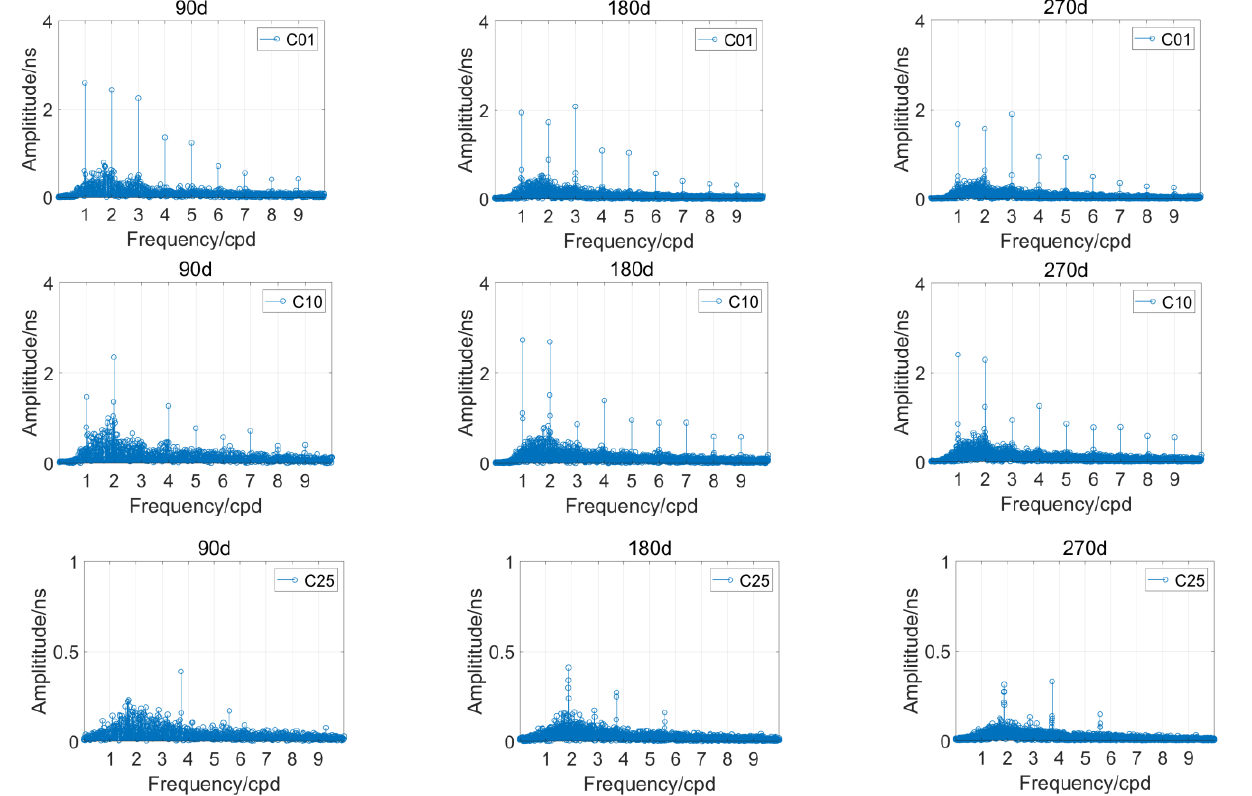
Figure 2. Amplitude spectrums of 90-day, 180-day, and 270-day for C01, C10, and C25. From Figure 2, the periodic terms in clock offsets are detected at multiple frequencies.